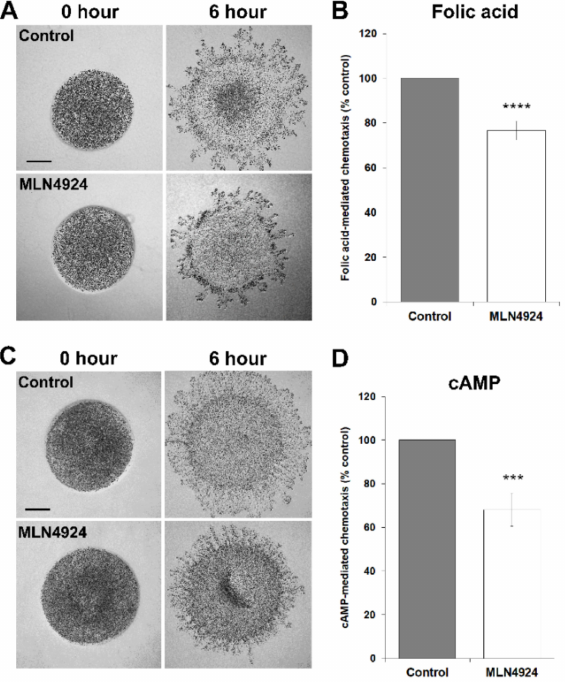
Figure 4. Effect of MLN4924 on folic acid-mediated and cyclic adenosine monophosphate (cAMP)- mediated chemotaxis. ( A ) Cells were deposited onto 0.5% agar/KK2/folic acid (50 µ M) in the presence and absence of MLN4924 (50 µ M, control: dimethyl sulfoxide). Images were taken once cells were deposited (0 h) and after 6 h. Scale bar = 500 µ m. ( B ) The amount of migration towards folic acid was quantified as detailed in the Section 2. Data are presented as the mean folic acid-mediated chemotaxis (% control) ± SEM ( n = 13). ( C ) Cells were deposited onto 0.5% agar/KK2/cAMP (10 µ M) in the presence and absence of MLN4924 (50 µ M, control: dimethyl sulfoxide). Images were taken once cells were deposited (0 h) and after 6 h. Scale bar = 500 µ m. ( D ) The amount of migration towards cAMP was quantified as detailed in the Section 2. Data presented as mean cAMP-mediated chemotaxis (% control) ± SEM ( n = 18). Statistical significance in ( B ) and ( D ) was assessed using